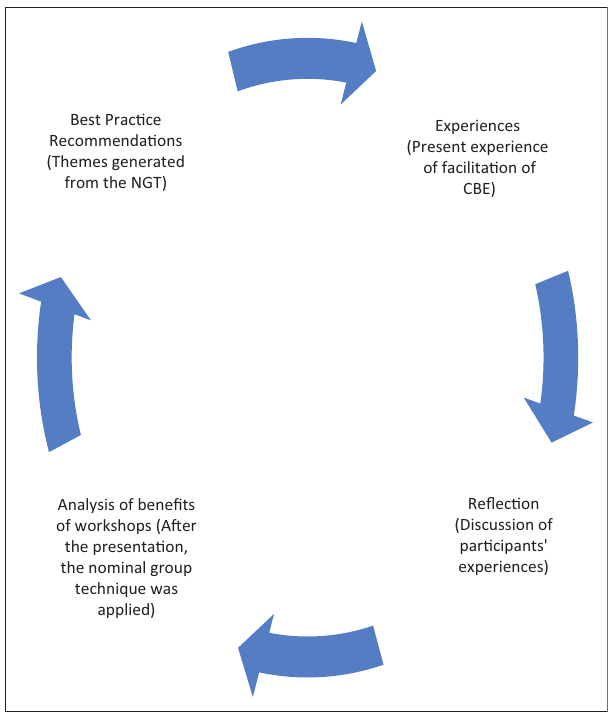
FIGURE 1: Application of the action